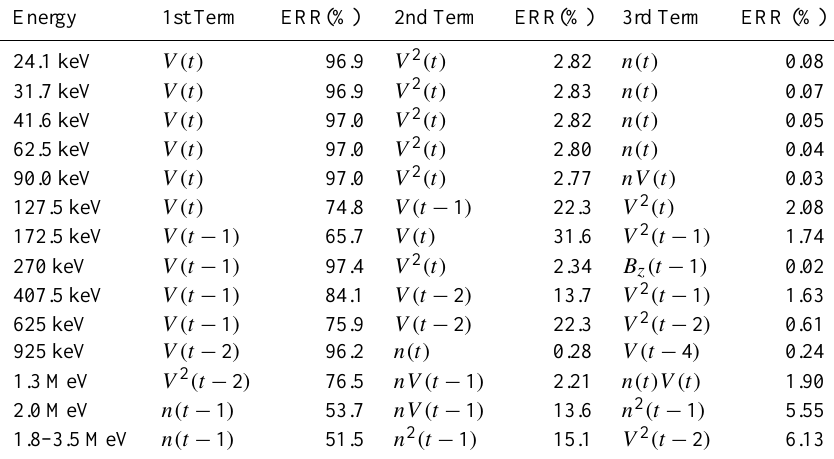
Table 4. Results of the NARMAX analysis, showing top 3 terms in the order of ERR for the electron fluxes ranging from 24.1keV to